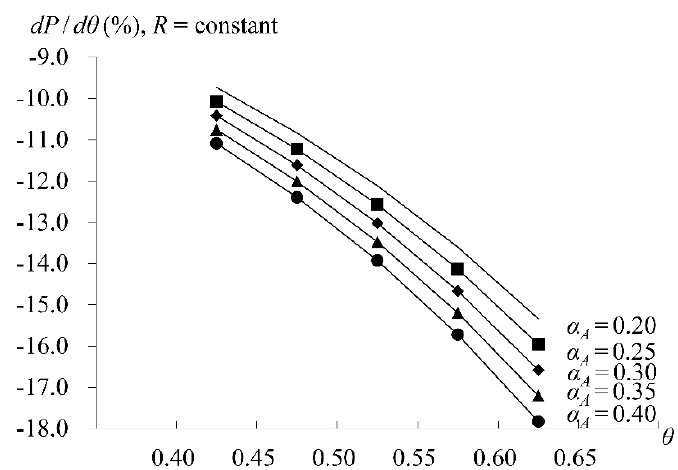
Figure 3. Responsiveness of default risk to buying distressed assets at various levels of CEO overconfidence based on Equation (18). Parameter values, unless stated otherwise, δ = 0.65, σ = 0.30, m = 0.10%, α = 0.95, R M = 5.00%, R B = 4.00%, β = 0.60, M = 60, and R = 2.25%. All results are valued at the optimal R A of 5.60%. The positive indirect effect, ( ∂ P / ∂ R A )( ∂ R A / ∂θ ) > 0, is consistently insufficient to offset the negative direct effect, ∂ P / ∂θ < 0 at various levels of CEO